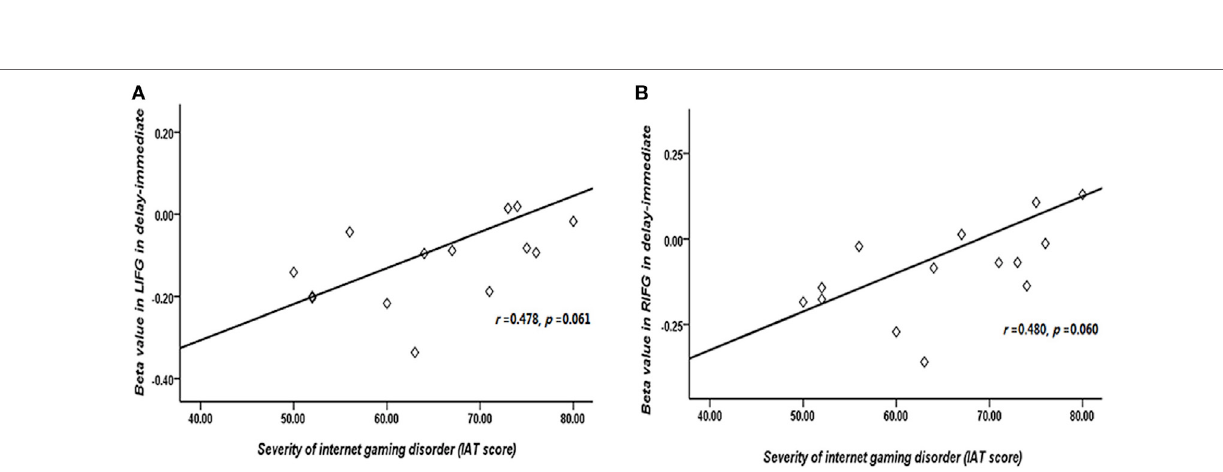
FigUre 7 | Correlation between the severity of Internet gaming disorder (IGD) and brain activations in the bilateral inferior frontal gyrus (IFG). (a) Correlation between peak left IFG activation (delay − immediate) and the severity of IGD. (b) Correlation between peak right IFG activation (delay − immediate) and the severity of IGD. (Scores that greater than 3 SDs were regarded as outliers and were excluded from further analysis.)